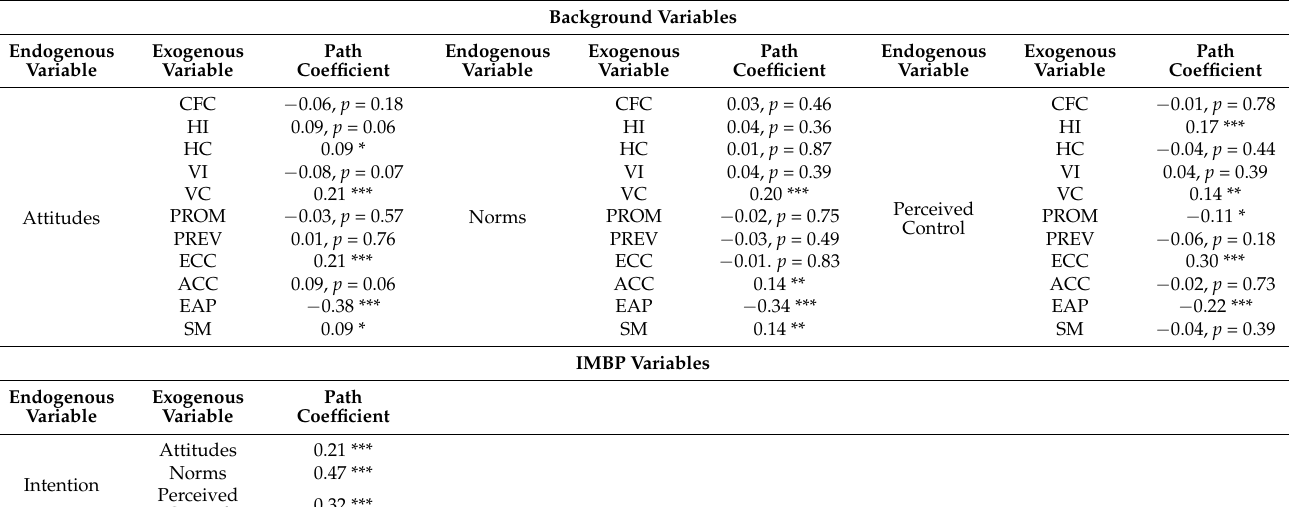
Table 3. SEM path